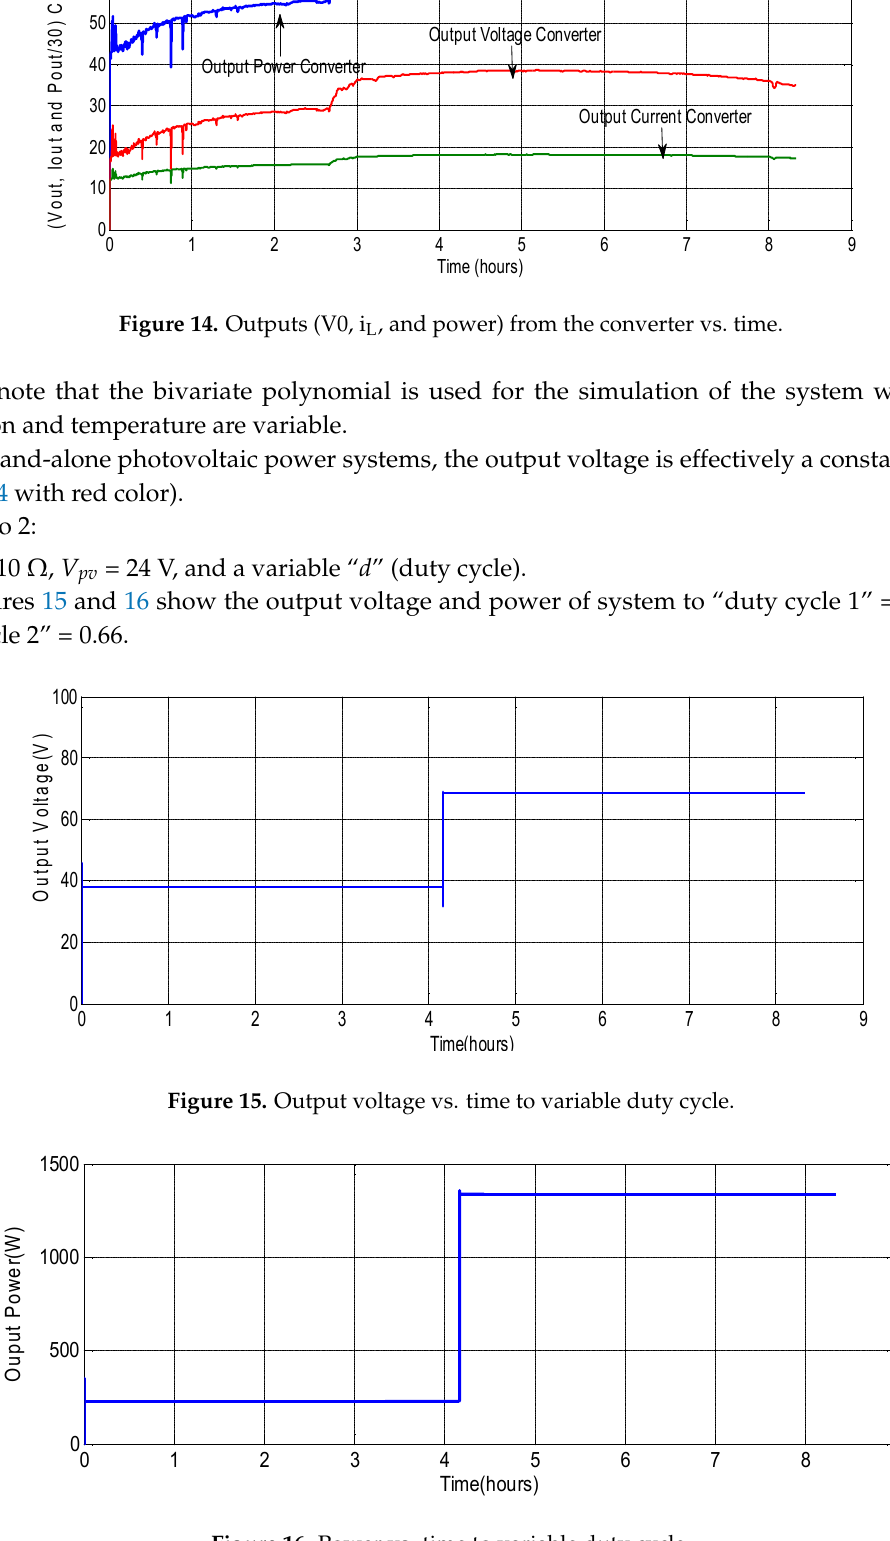
Figure 13. Inputs (d, Vpv, and E) into the converter vs. time.